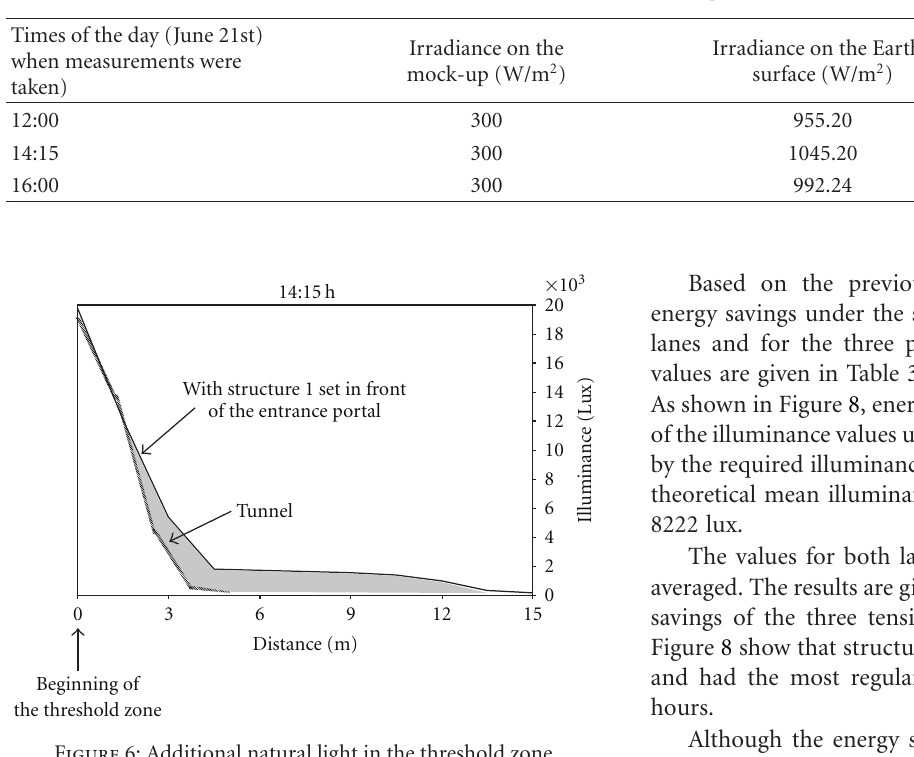
Figure 5: Tension structures placed at the entrance of the tunnel. (a) Structure type 1. (b) Structure type 2. (c) Structure type 3. Table 1: Correction factors used to convert mock-up values into Earth surface values.